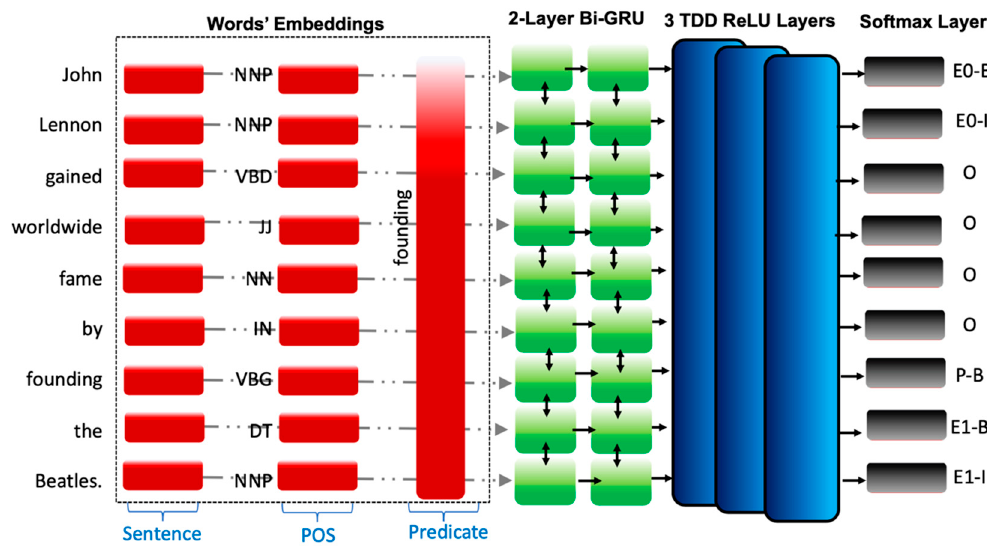
Figure 2. Our ROIE transferable neural model architecture.